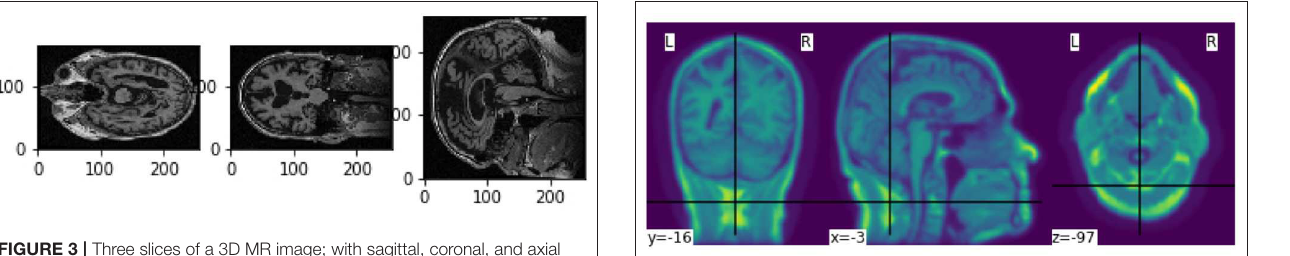
FIGURE 4 | Smoothed MR image with Gaussian